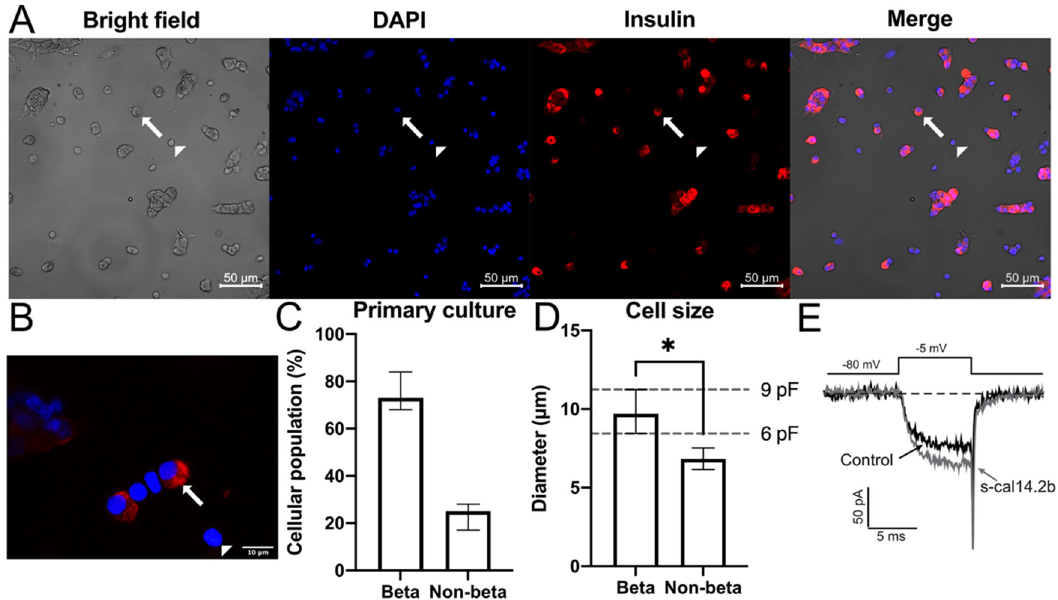
Figure 3. Pancreatic β -cell identification in primary cultures by immunofluorescence. ( A ) Brightfield microscopy was used to identify the cellular membrane. DAPI staining (blue) was used to identify the cellular nucleus in primary pancreatic β -cell culture at a ( A ) 40 × second column and ( B ) 100 × magnification. Insulin was detected (red) at ( A ) 40 × third column and ( B ) 100 × magnification. Cell images were merged at ( B ) 100 × and ( E ) 40 × magnification. The white arrow shows a typical pancreatic β -cell while the white arrowhead shows a typical non- β cell. Graphs beneath the cell image panels depict the percentage of β -cells in primary cultures ( C ) as the median ± 95% C.I. of insulin positive cells and the differences in cellular size between pancreatic β -cells and non- β cells ( D ) expressed as the median ± 95% C.I. of diameter. * indicates a difference with p value <0.05. The dashed lines indicate the corresponding 95% C.I. range for the recorded conductance values. For control conditions, a representative whole-cell patch-clamp calcium current in pancreatic β -cells is shown in black. The increase in calcium current induced by s-cal14.2b administration is indicated in gray.